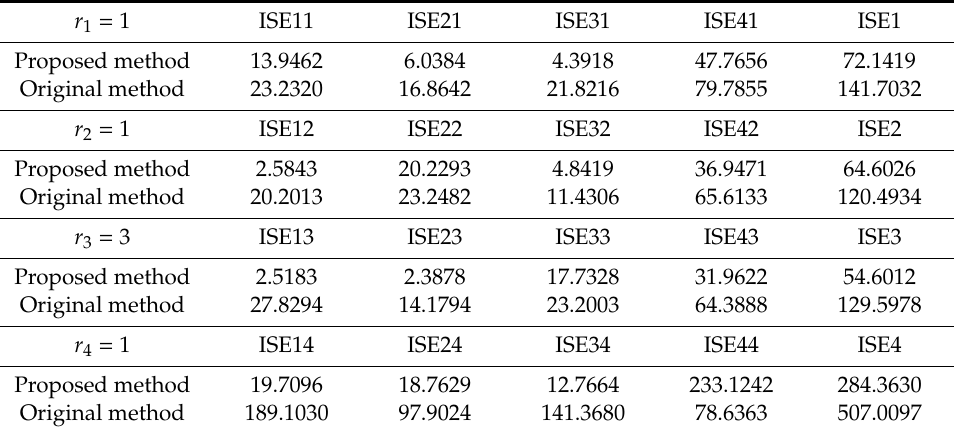
Table 1. Comparison of the ISE values.